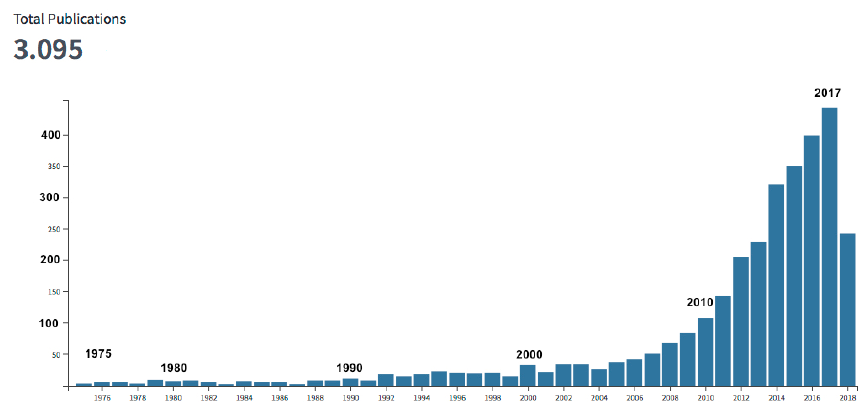
Figure 4. Number of publications with the word “microspher*” in the title and “energy” among the topics. Data from Clarivate Analytics Web of Science; search performed on 21 July 2018.